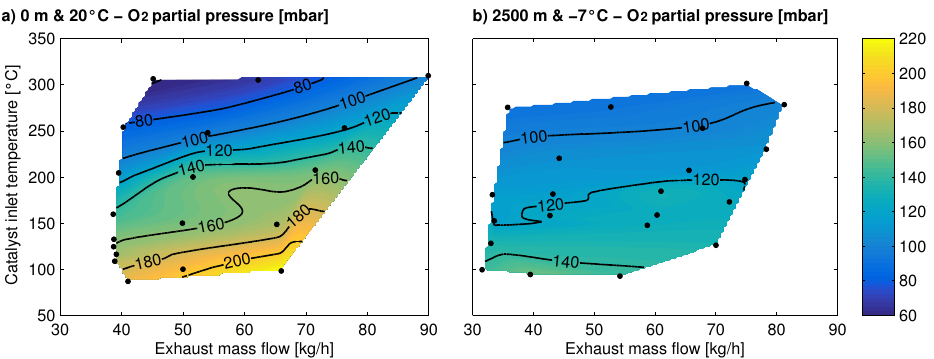
Figure 8. O 2 partial pressure as a function of the exhaust mass flow and catalyst inlet temperature: ( a ) 0 m and 20 ◦ C; ( b ) 2500 m and − 7 ◦